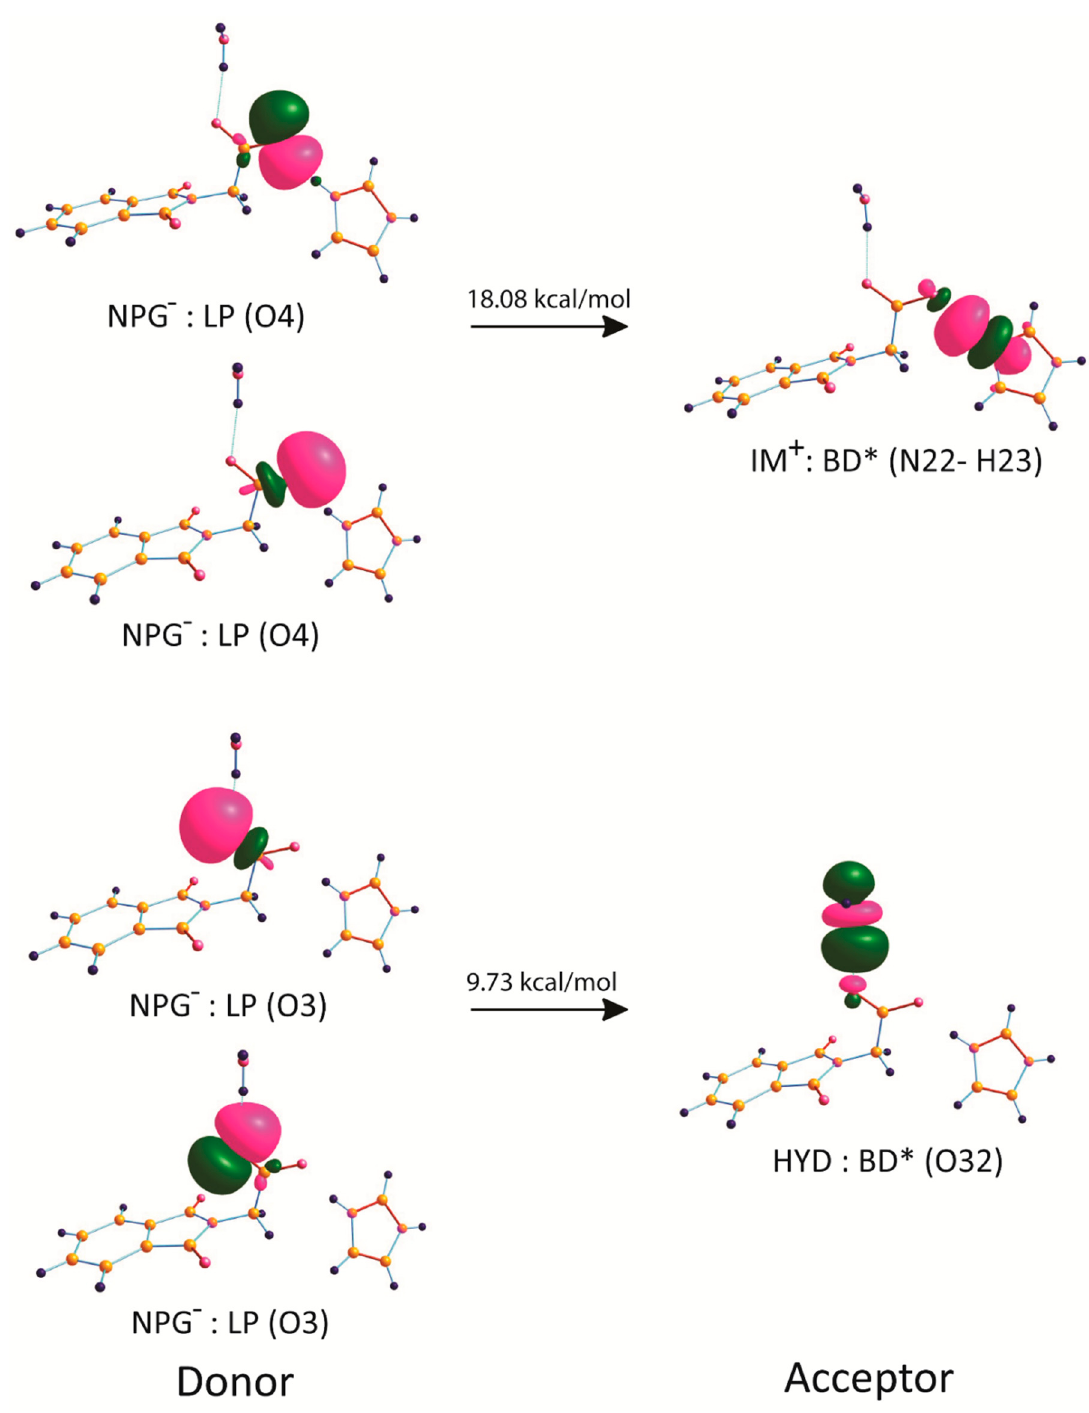
Figure 12. LP → BD* donor-acceptor orbitals’ interaction derived from the NBO analysis of IM + –NPG − –HYD (for configuration A ). Hydrogen atoms are omitted for clarity (isovalue = 0.03).